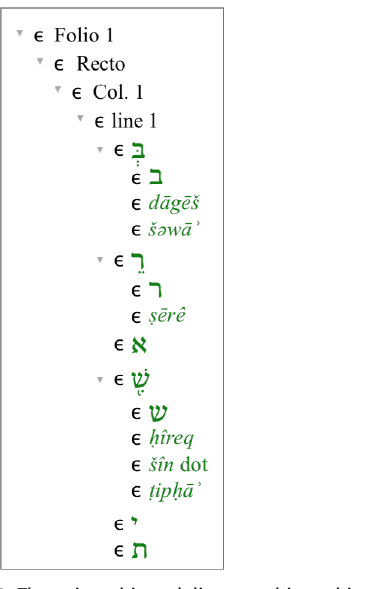
Figure 4: The epigraphic and discourse hierarchies in